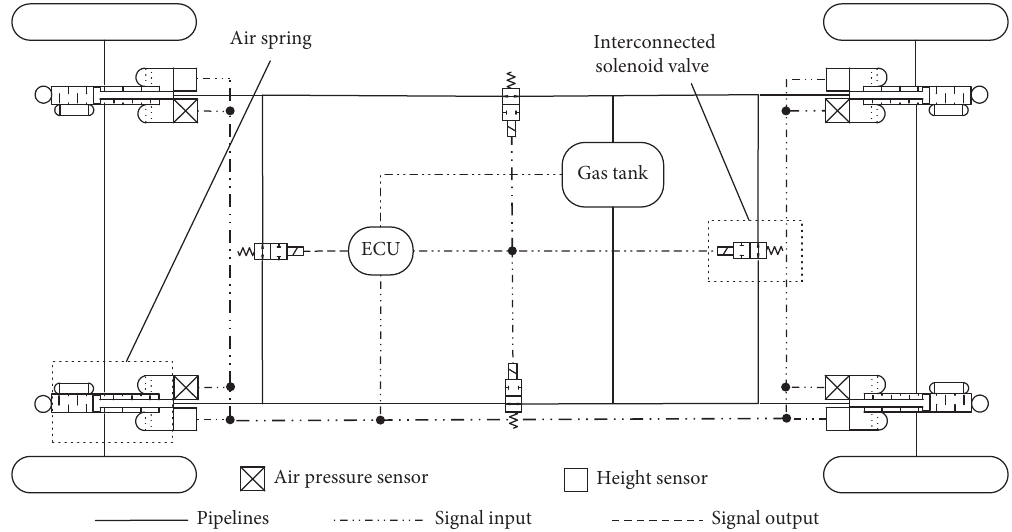
Figure 1: Structure of the four-corner interconnected air